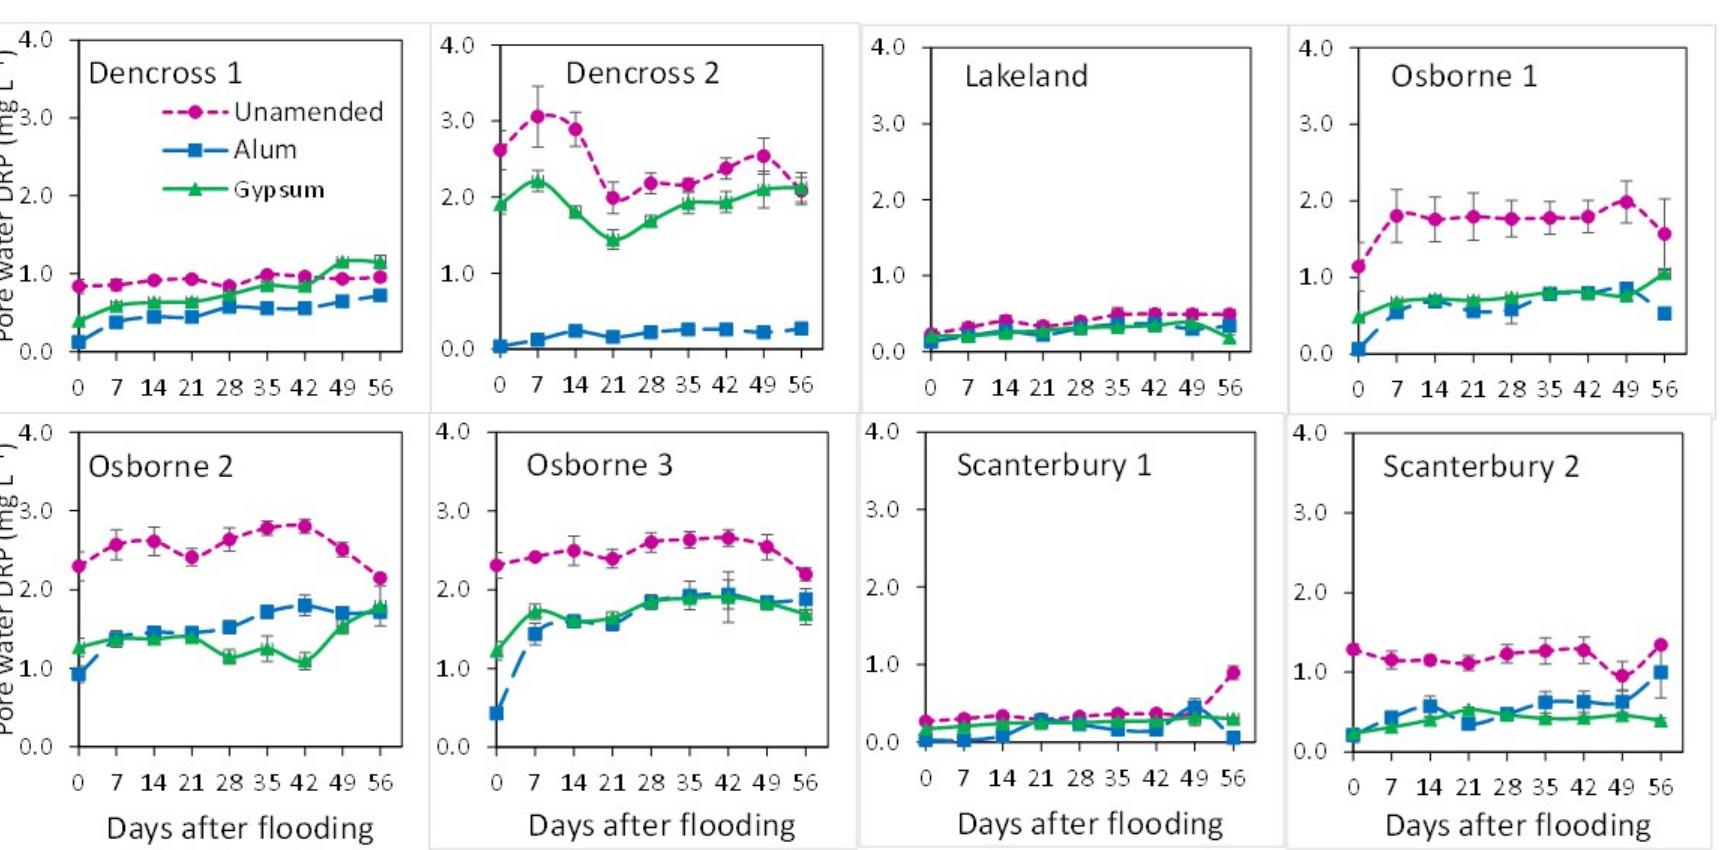
Figure 1. Mean porewater dissolved reactive P concentrations in unamended, alum-amended and gypsum-amended soil monoliths with time of flooding. The vertical bars indicate the standard deviation of the means (n = 3).